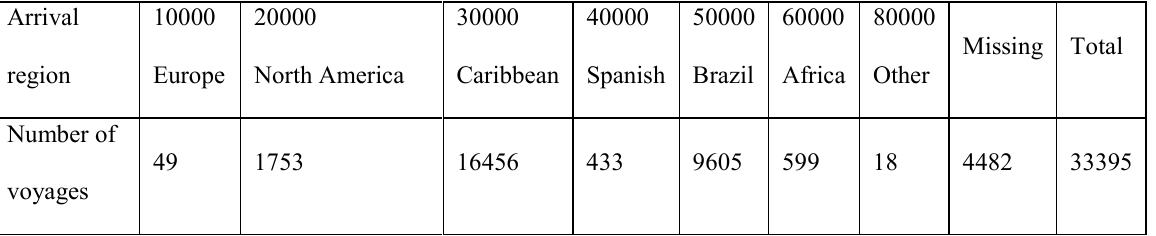
Table 3. TASTDB-2010 records by arrival region, 1650s to